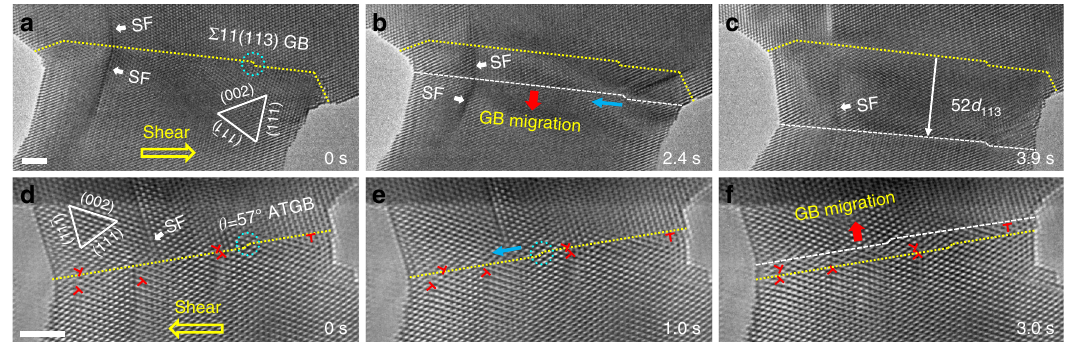
Fig. 5 Disconnection-mediated migrations of different GBs in Au bicrystals. a – c Disconnection-mediated migration of a Σ 11(113) coherent GB in an Au bicrystal with pre-existed stacking faults (SFs, indicated by the white arrows). Similarly, the successive motion and interplay of GB disconnections caused a downward migration of this Σ 11(113) GB, and the presence of SFs had limited in fl uence on the GB migration. d – f Upward migration of a θ = 57° < 110 > asymmetrical tilt GB (ATGB) with numerous pre-existed full dislocations near the GB. d , e The GB disconnection moved laterally towards left under shear loading and passed a pair of full dislocations, without any evident interaction. f Successive lateral motion of disconnections caused an upward migration of the GB. The dislocations near the GB remained almost static and had limited effect on the lateral motion of disconnections. The aqua circles in ( a ), ( d ) and ( e ) mark out the pre-existed GB disconnections; the yellow, blue and red arrows indicate the directions of shear stress, disconnection motion and GB migration, respectively. The yellow dotted lines and the white dashed lines represent the initial and fi nal positions of the GBs, respectively. Scale bars: 2